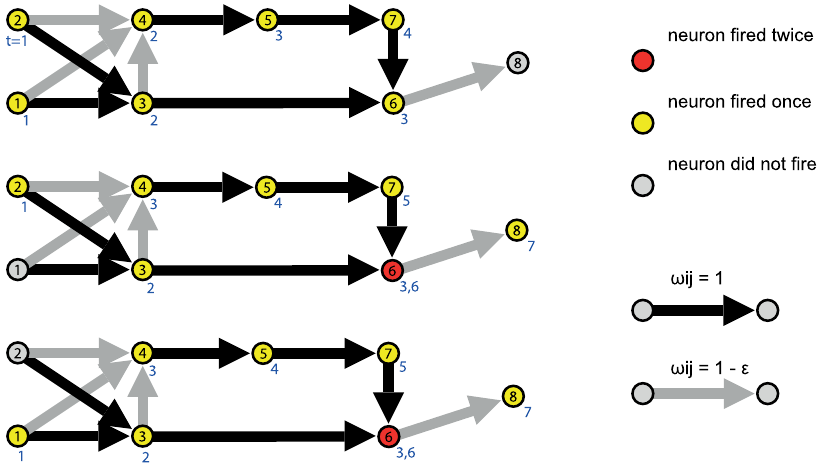
Figure 2. XOR gate with only excitatory neurons. The figure above shows a possibility for a XOR gate with only excitatory neurons with a refractory period of one time-step. The blue numbers below each neuron indicate at which time step the neuron fires.